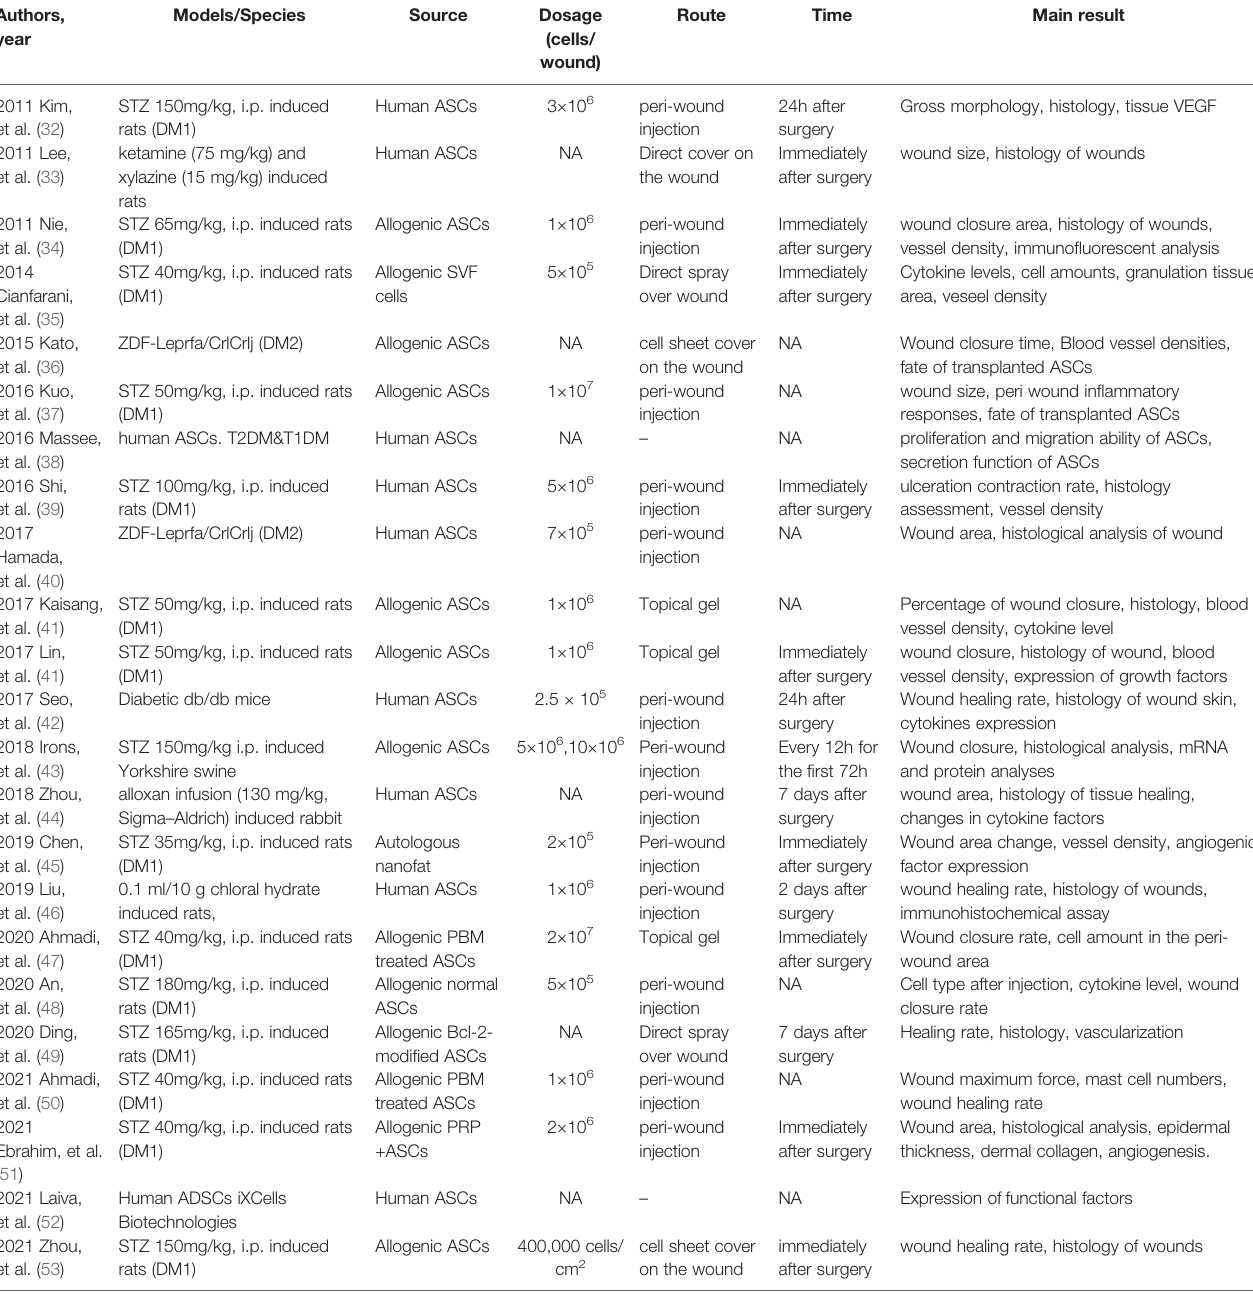
TABLE 2 | Summary of ASCs treatment on diabetic wounds in animal